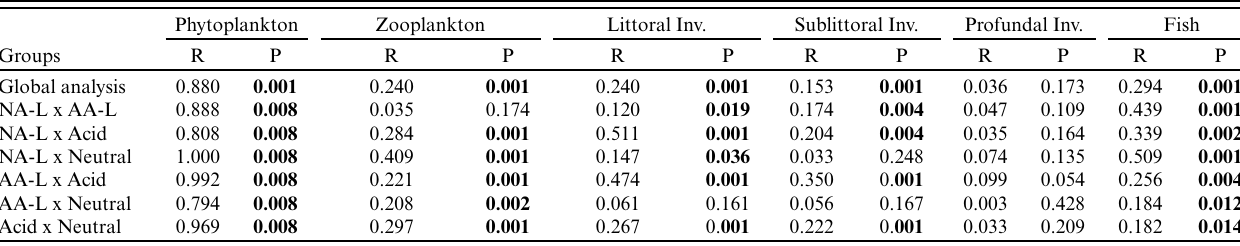
Table 2 . ANOSIM analysis showing global results and pairwise comparison between lake types (NA-L, naturally acidic-limed; AA-L, acidified-limed; acid, acidified; neutral, circumneutral). Shown are R statistics and significance levels. Significant P values are highlighted in bold. Phytoplankton Zooplankton Littoral Inv. Sublittoral Inv. Profundal Inv. Fish